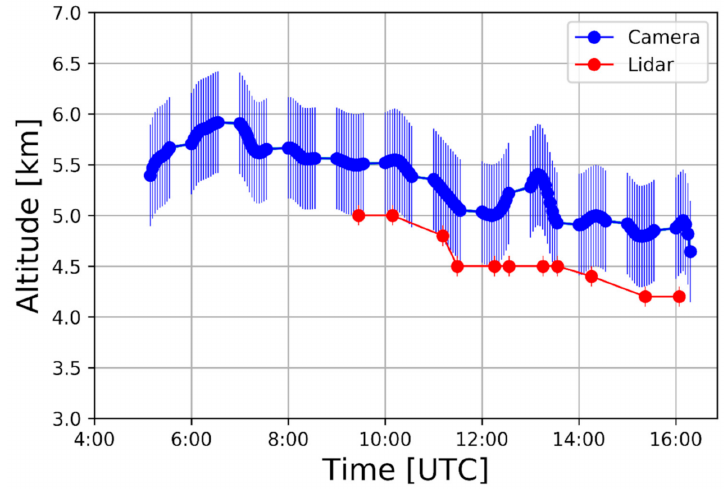
Figure 2. Column height retrieved by the visible calibrated EBVH (Etna Bronte Visible High definition) camera (blue line) at the summit craters and volcanic plume height retrieved by Lidar in Catania (red line) located at 25 km far from the volcanic source. Camera data are from 05:15 to 16:35 on 28 December 2018 with a time step of 5 min, and Lidar data are from 09:45 to 16:07 with a time step of 30 min.